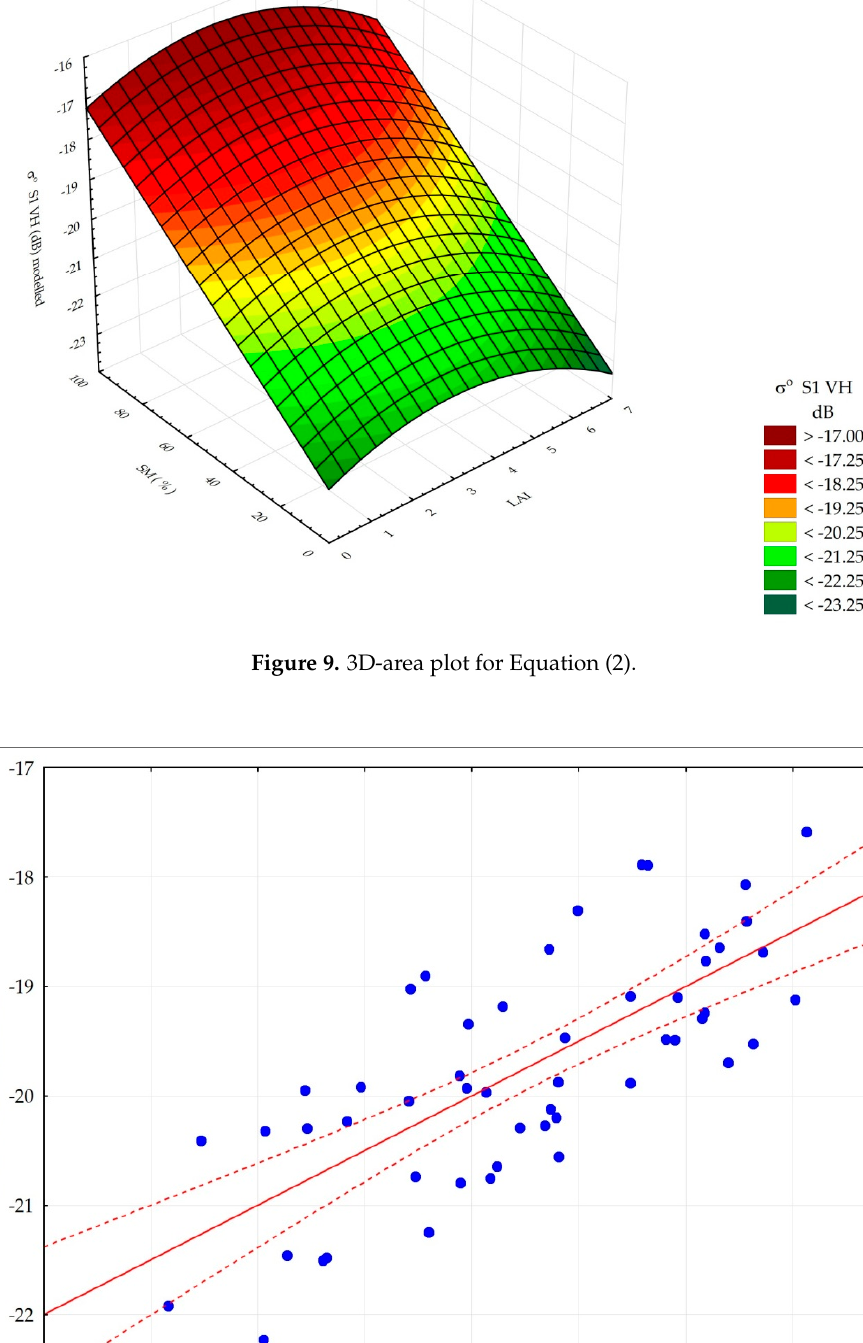
11 of 22 Figure 8. Relationship between σ ° VH observed and predicted by applying Equation (2). The partial correlations for the particular components have been examined. For the model presented by Equation (2) the R was equal to 0.85 for SM, and for LAI—R was equal to 0.22 (expression of LAI in Equation (2) was treated as one component). It means that the influence of SM for the explanation of the variance of σ ° VH, after establishing the influence of LAI, is several times